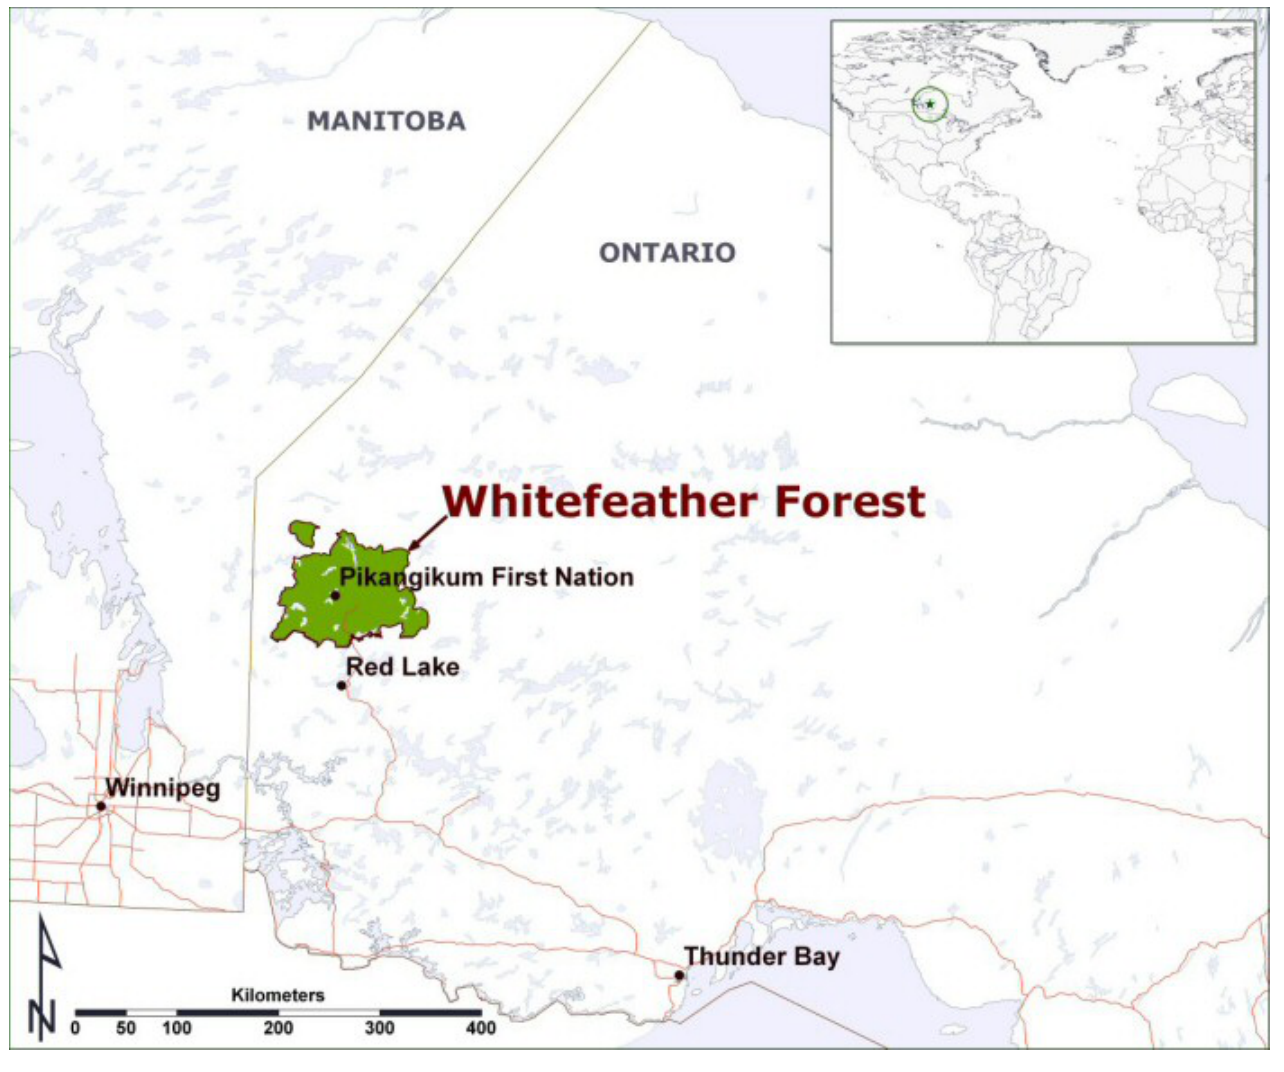
Fig. 1. The Whitefeather Forest: an area of provincial Crown land that represents the portion of Pikangikum traditional territories in which forest management and other new land uses, including protected areas management, have been proposed through the community-based land-use planning